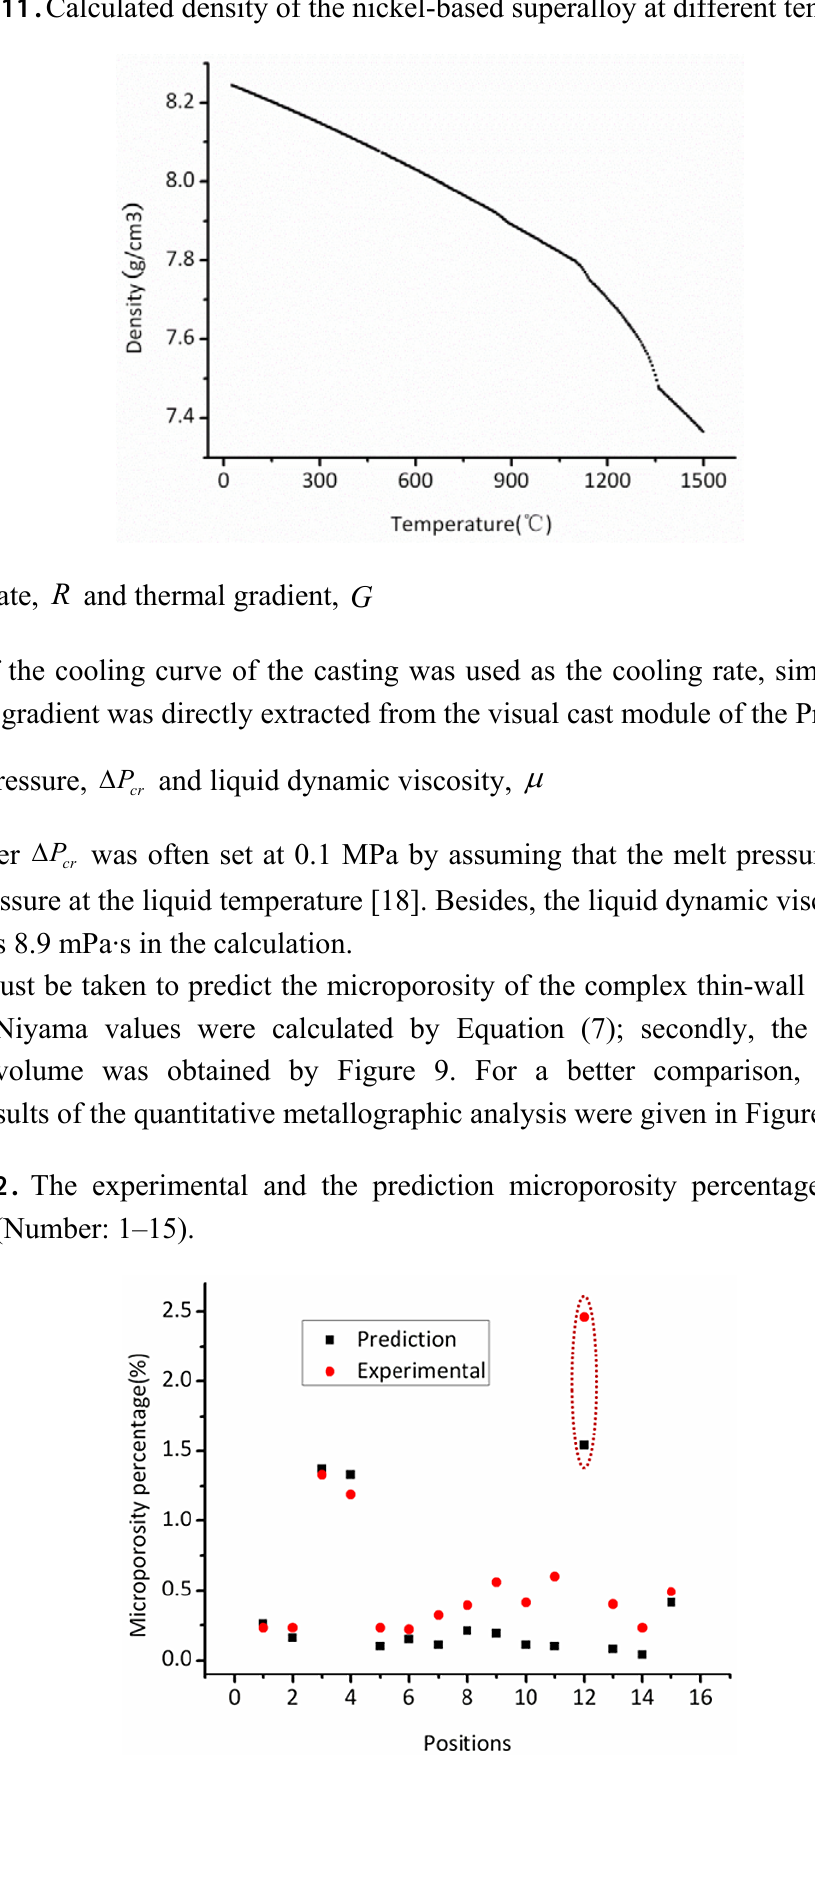
Figure 11. Calculated density of the nickel-based superalloy at different